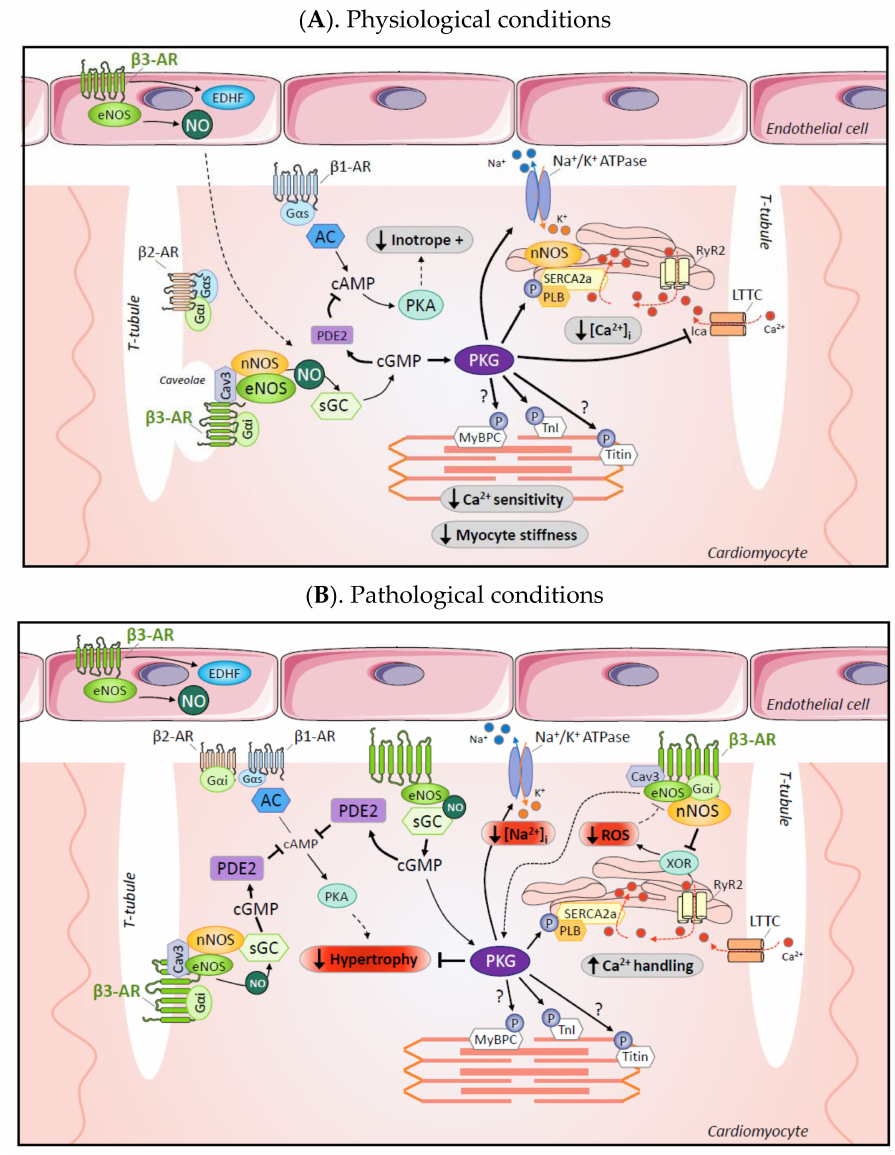
Figure 1. Coupling to cardiac intracellular signaling by the β 3-AR in physiological and pathological conditions. ( A ). In physiological conditions, β 3-AR are mainly localized in T-tubular membranes where they couple to both eNOS and nNOS; NO production results in the production of a localized pool